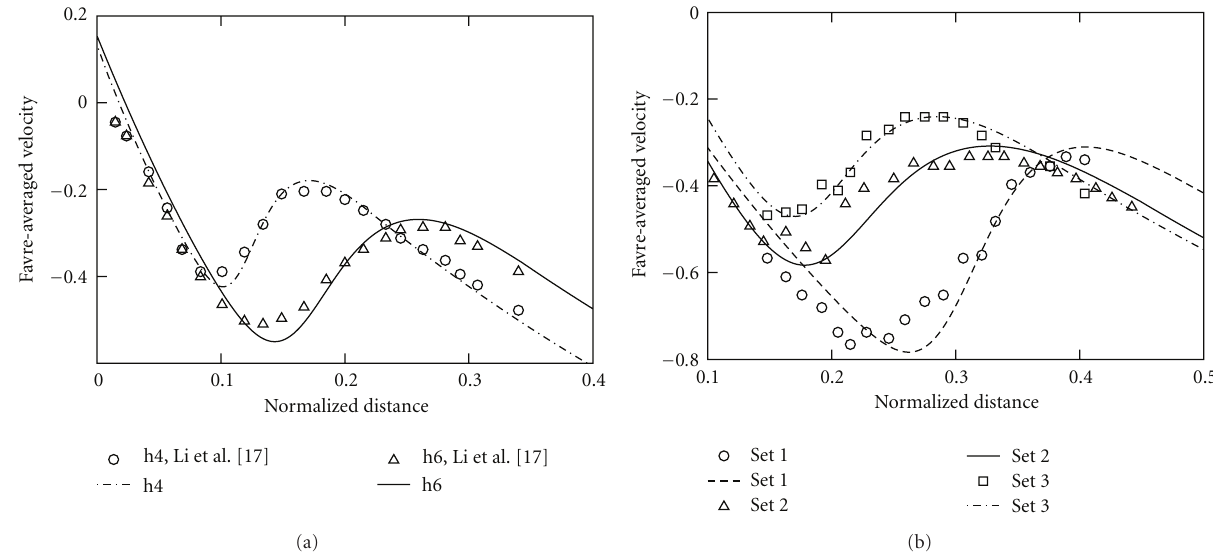
Figure 4: Axial profiles of the normalized Favre-averaged axial velocities (cid:6) w ( z ) in flames investigated by Li et al. [17] (a) and by Stevens et al. [18] (b). Symbols show experimental data. Curves have been computed.